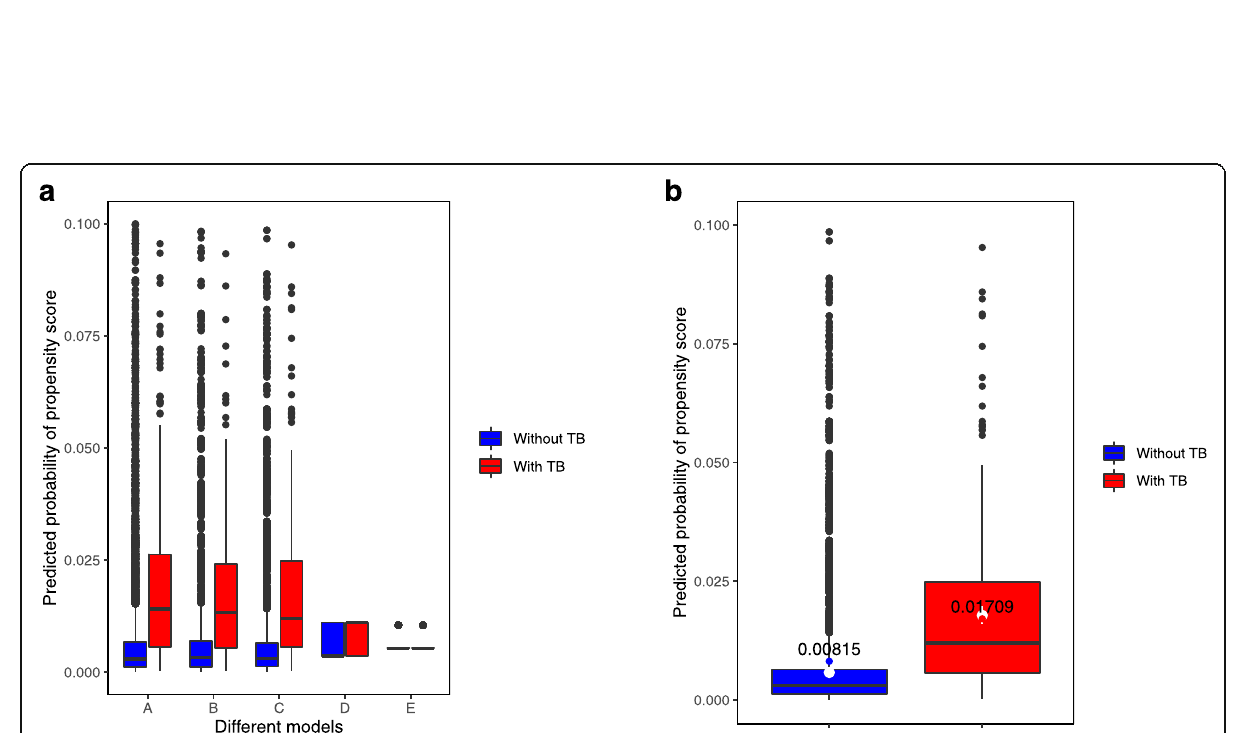
Fig. 4 a Discrimination box plot of various TB screening models A to E. b Discrimination box plot of social pathology model C (Bootstrap